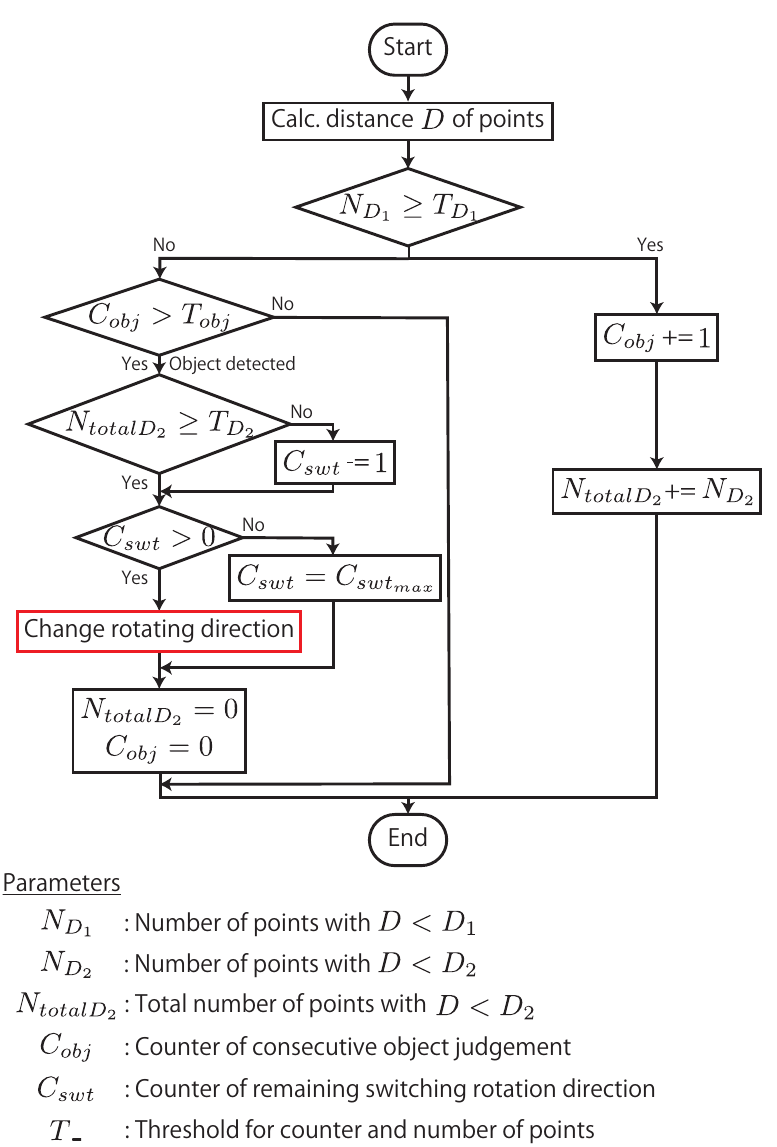
Figure 8. Flowchart of control algorithm for direct drive